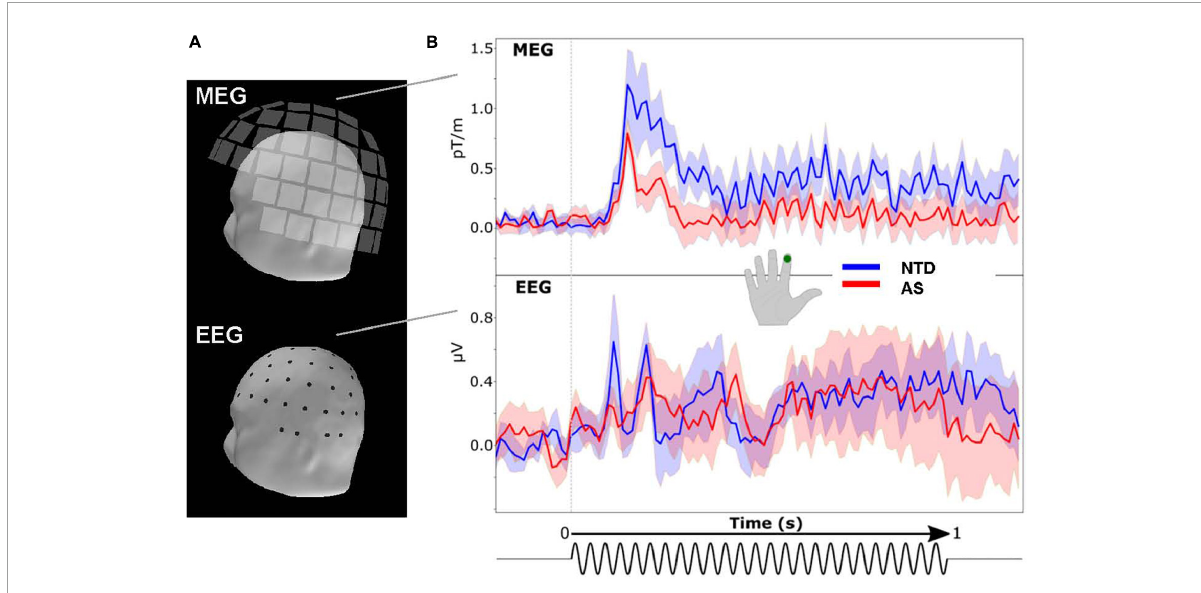
FIGURE1 Averaged evoked response to 25-Hz vibrotactile stimulation of the index finger of the right hand. (A) Layout of the MEG ( top ) and EEG ( bottom ) sensor arrays. The squares represent MEG triple-sensor units (one magnetometer and two planar gradiometers) and the dots EEG scalp electrodes. (B) Waveforms from one representative left-hemisphere MEG planar gradiometer and EEG electrode were averaged over the subjects in the NTD ( blue ) and AS ( red ) groups; shading shows standard error across subjects. The time course of the stimulus is shown at the